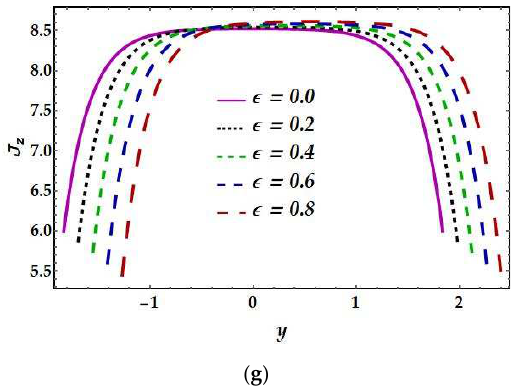
Figure 5. Effects of different physical parameters on current density J z .